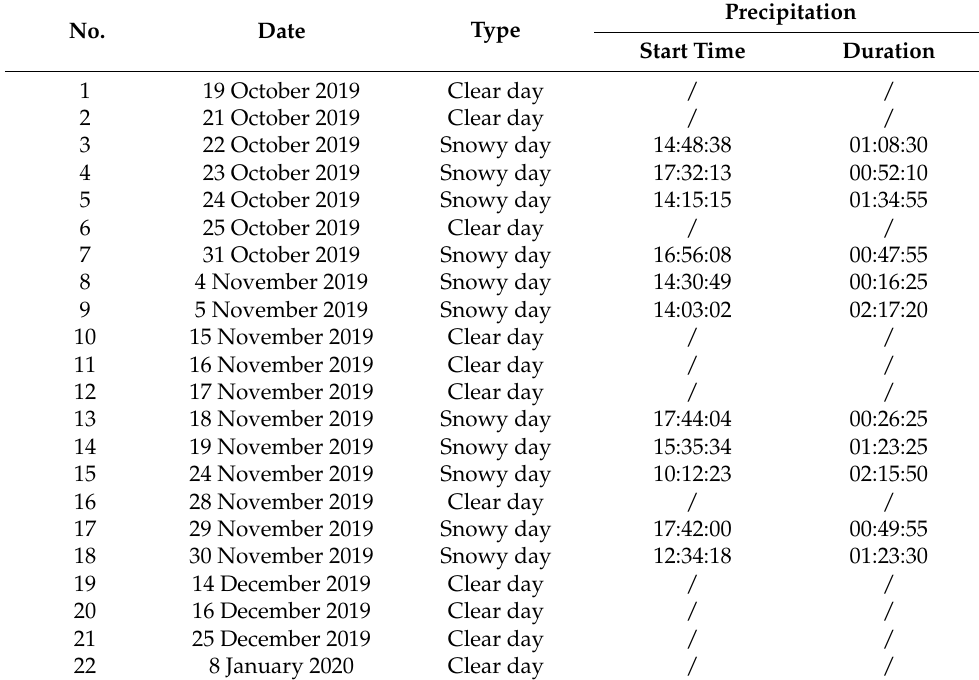
Table 1. Schedule of field experiments of meteorological